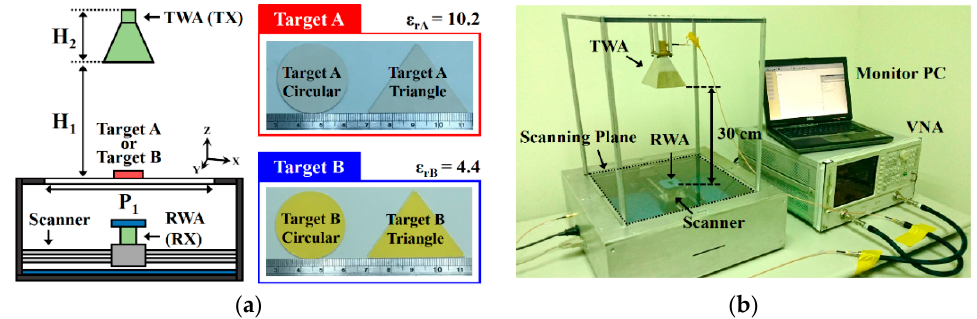
Figure 2. Configuration of the waveguide antenna microwave imaging sensing system. ( a ) The material thickness of target A and target B were 0.8 mm and 2.5 mm, respectively, and ( b ) photograph